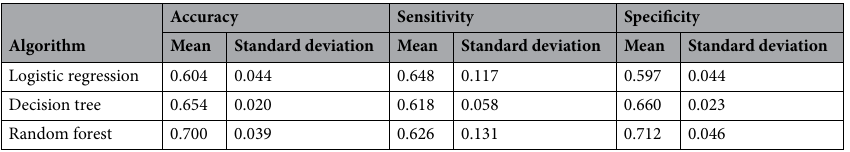
Table 4. Comparison of the performance in RUTI prediction models in the clinical visit through fivefold cross validation (sample size = 963). Abbreviation: RUTI, recurrent urinary tract infection.